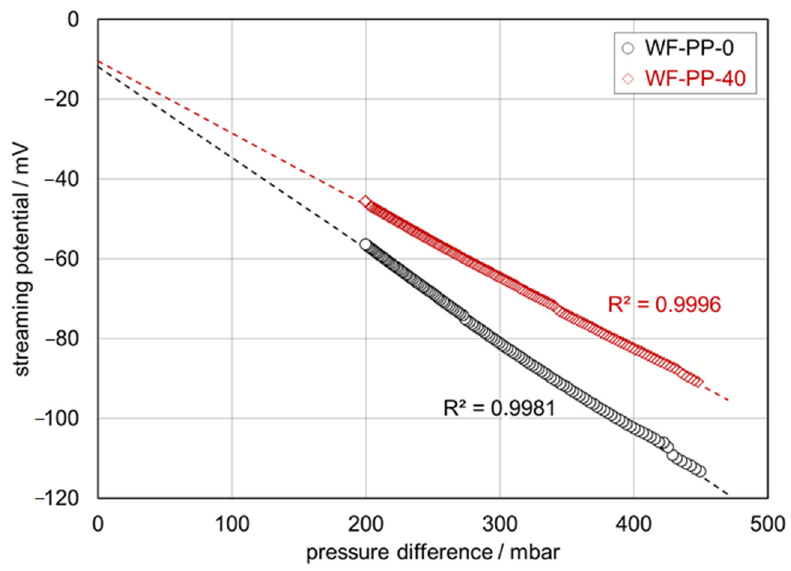
Figure 10. Pressure ramps (streaming potential vs. pressure difference) for WF-PP-0 and WF-PP-40 in 0.001 moL/L KCl at pH 6.1.